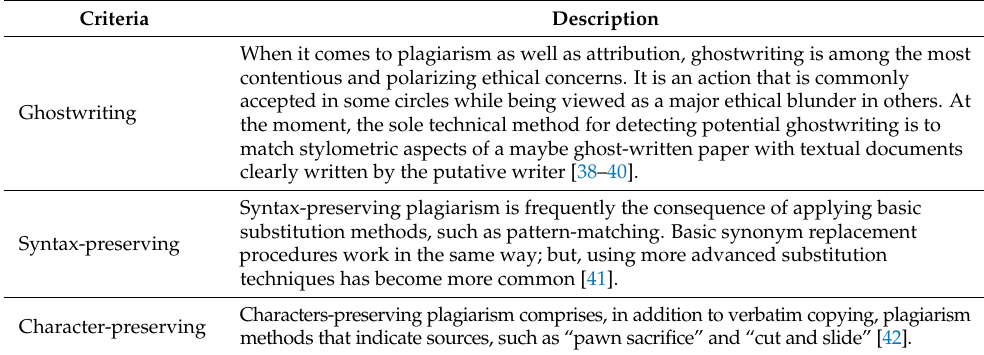
Table 1. Different criteria for the